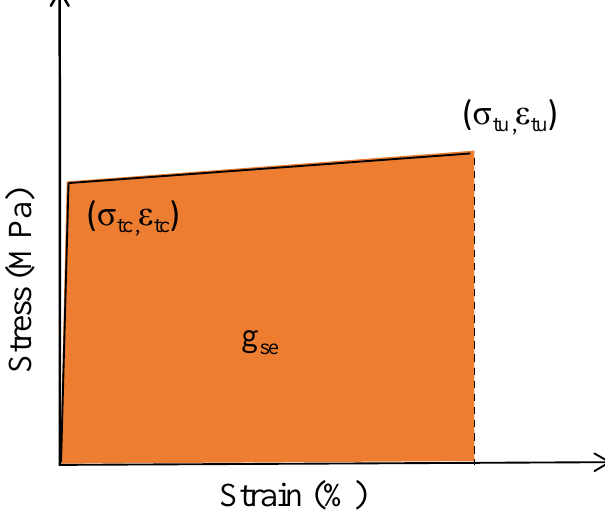
Figure 8. Modeled tensile stress-strain curve and critical parameters.